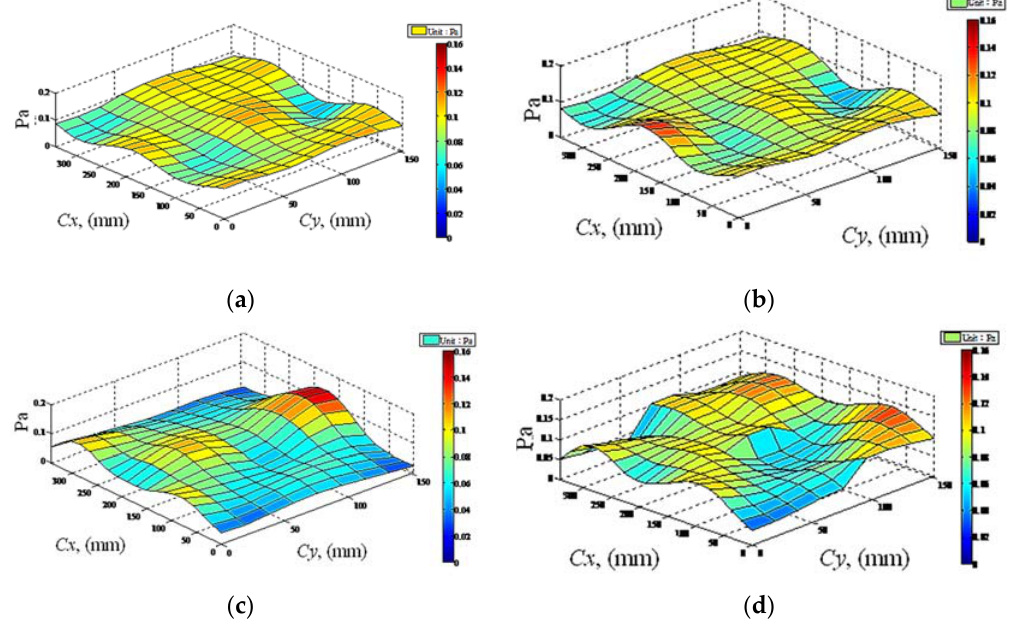
Figure 25. Sound field measurements obtained within the zone affected by the cloak shell: ( a ) only the specimen supporter as a reference sound field; ( b ) the object; ( c ) the cloak shell; ( d ) the object and the cloak shell.